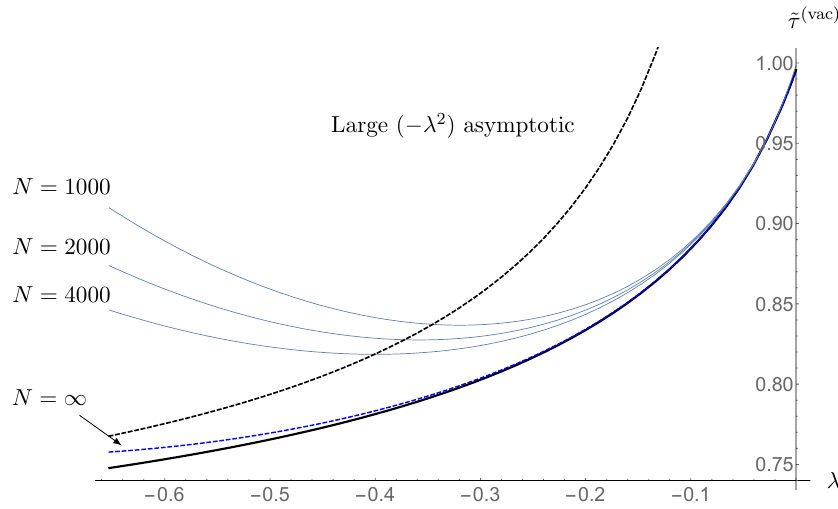
(cid:0) (cid:1) 2 (cid:25) ( (cid:0) (cid:21) 2 ) 3 2 for the parafermion